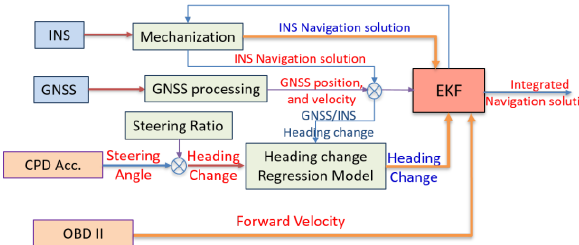
Figure 8. GNSS/INS loosely coupled navigation system scheme with updates based on CPD heading change and vehicle information